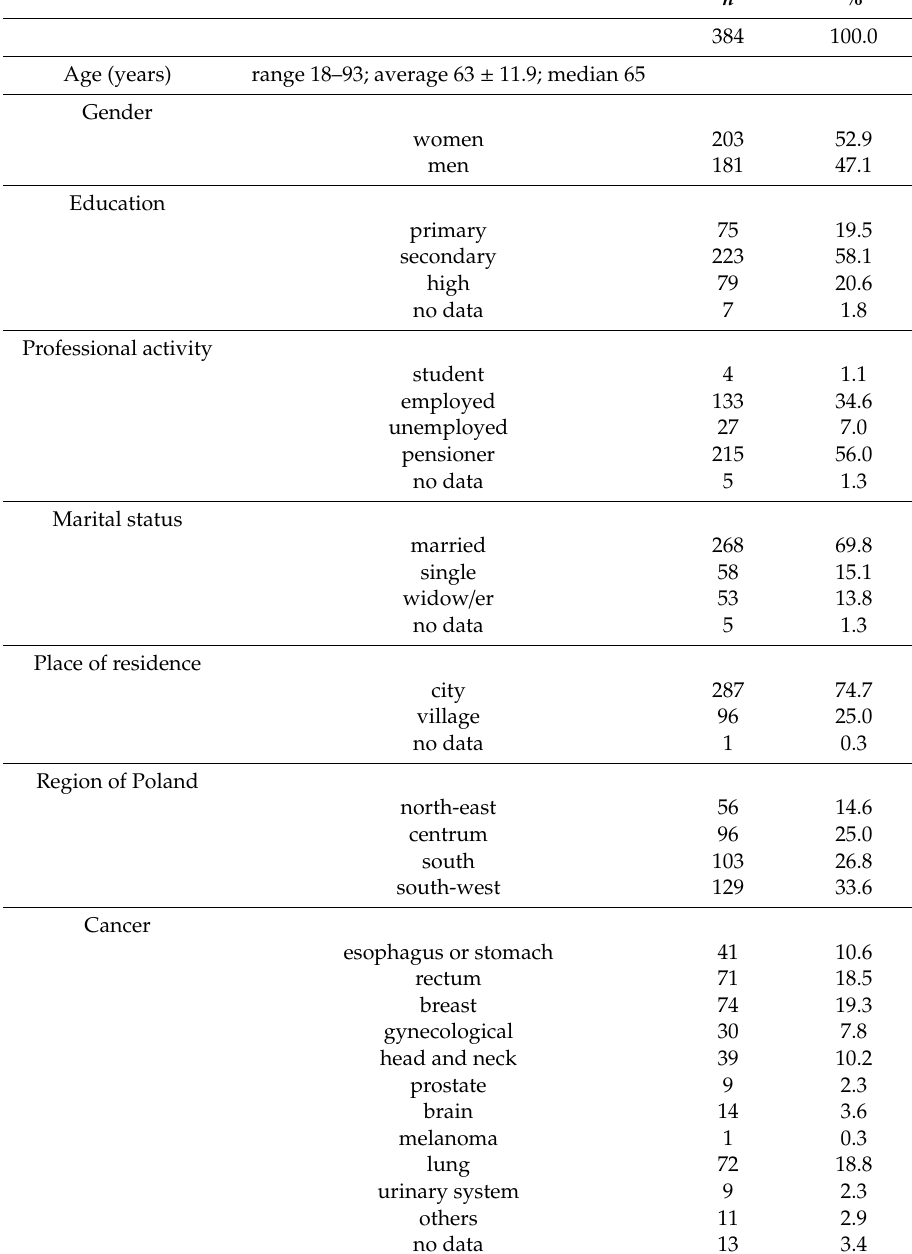
Table 1. Characteristic of